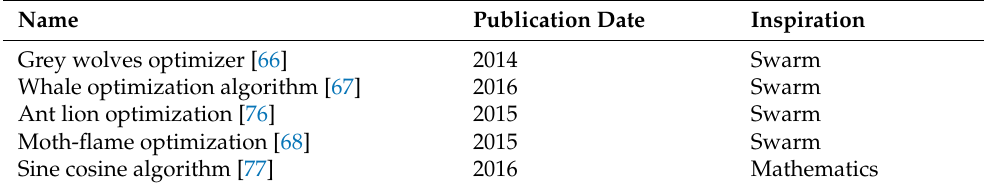
Table 2. Some promising recent metaheuristics.